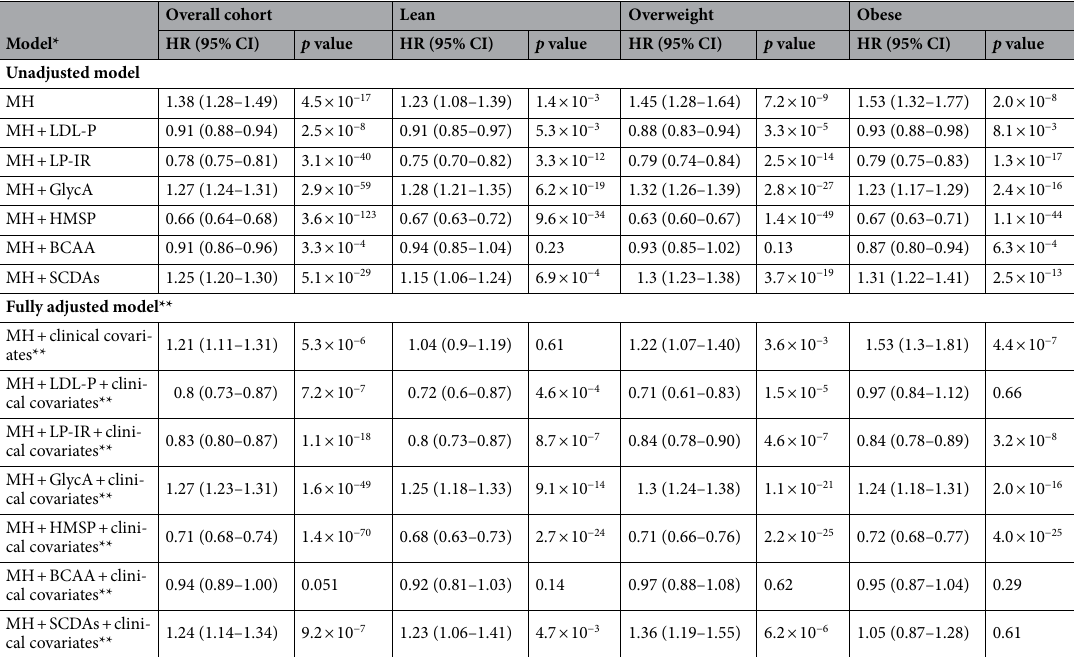
Table 2. Hazard ratios, confidence intervals, and p values for death or incident MI prediction for traditionally defined poor MH and novel plasma biomarkers in the overall cohort and stratified by BMI category. *MH models included 8671 samples; LDL-P, LP-IR, GlycA, and HMSP models included 8385 samples; BCAA and SCDA models included 3591 samples. **Clinical covariates include: age, sex, race, LVEF, CAD, family history of CAD, smoking, LDL-C, and